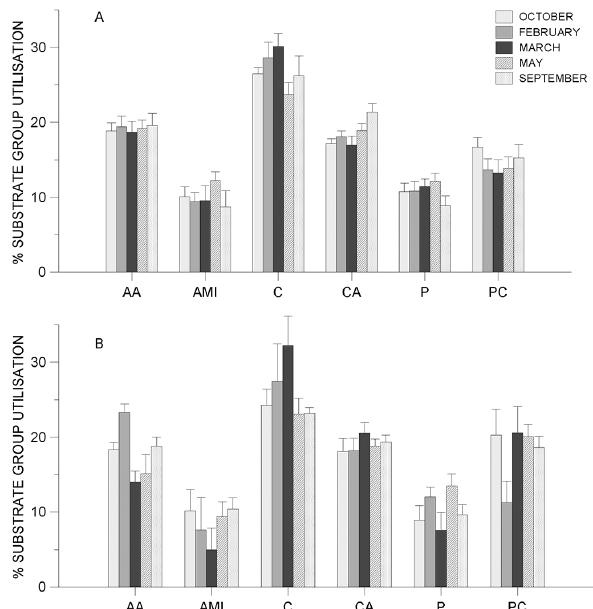
Figure 10. Changes in percentage utilization of substrate groups (AA – amino acids, AMI – amines, C – carbohydrates, CA – car- boxylic acids, P – polymers, PC – phosphorylated compounds) in the productive layer (A) ; and deeper layers (B) during the cruises (3 October 2011, 18 February 2012, 29 March 2012, 30 May 2012 and 10 September